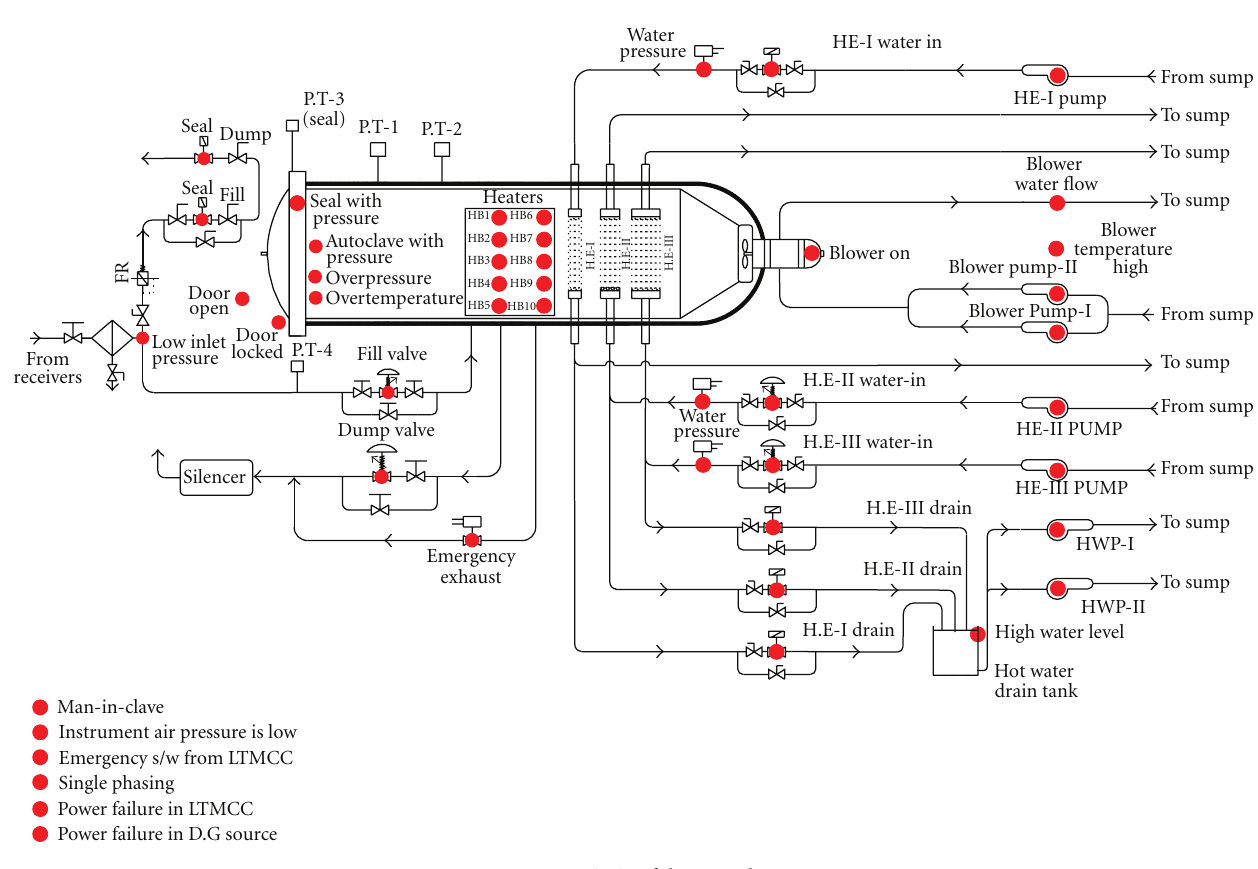
Figure 4: Mimic of the